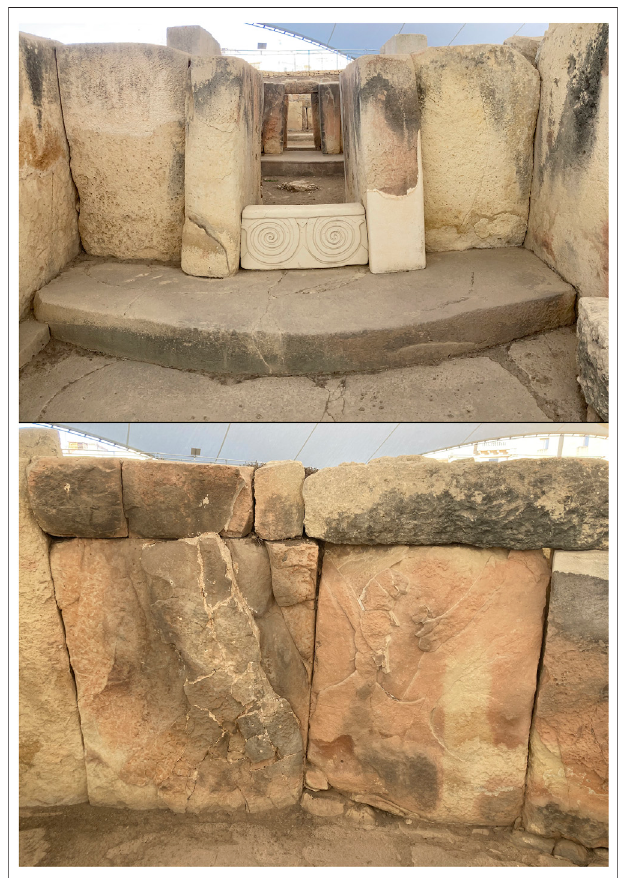
FIGURE 6 | Tarxien temple. Note fi re damage (reddened